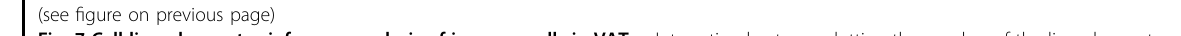
Fig. 7 Cell ligand-receptor inference analysis of immune cells in VAT. a Interaction heatmap plotting the number of the ligand-receptor pairs between each immune cell type in VAT. Crosstalk of immune cells in VAT from patients without CAC is shown in the upper area, while that from patients with CAC is shown in the lower area. b Connectome web analysis of interacting immune cells based on the expression of paired ligands and receptors. The size of nodes denotes the number of pairs involved in each cell type, and the color saturation of the line is proportional to the amount of the pairs between two nodes. c Dot plots showing the expression of ligands (left) and receptors (right) implicated in the interaction pairs of CD8 + T cells in each immune cell type. Color saturation re fl ects the log 2 fold-change of the indicated gene expressed in cells from patients with cachexia compared with patients without